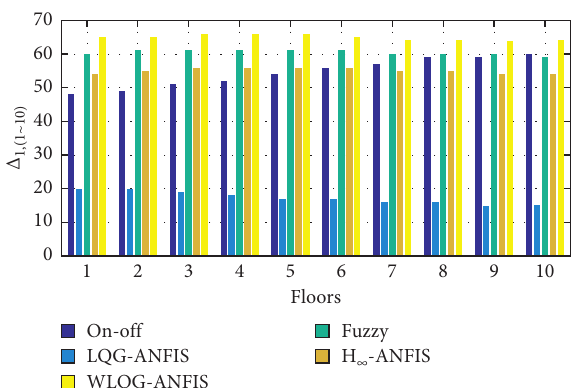
Figure 15: Performance indexes for five control strategies for all the displacements.